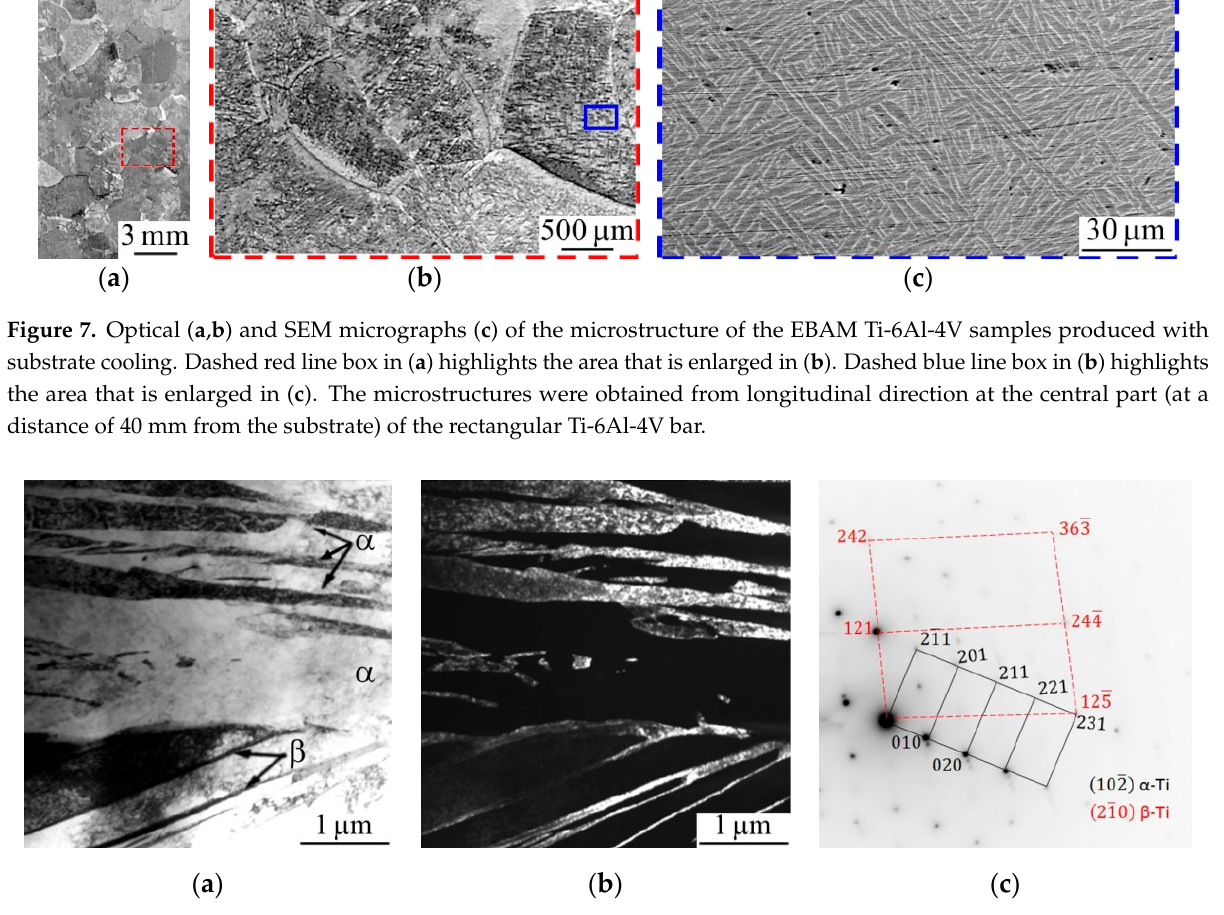
Figure 7. Optical ( a , b ) and SEM micrographs ( c ) of the microstructure of the EBAM Ti-6Al-4V samples produced with substrate cooling. Dashed red line box in ( a ) highlights the area that is enlarged in ( b ). Dashed blue line box in ( b ) highlights the area that is enlarged in ( c ). The microstructures were obtained from longitudinal direction at the central part (at a distance of 40 mm from the substrate) of the rectangular Ti-6Al-4V bar.